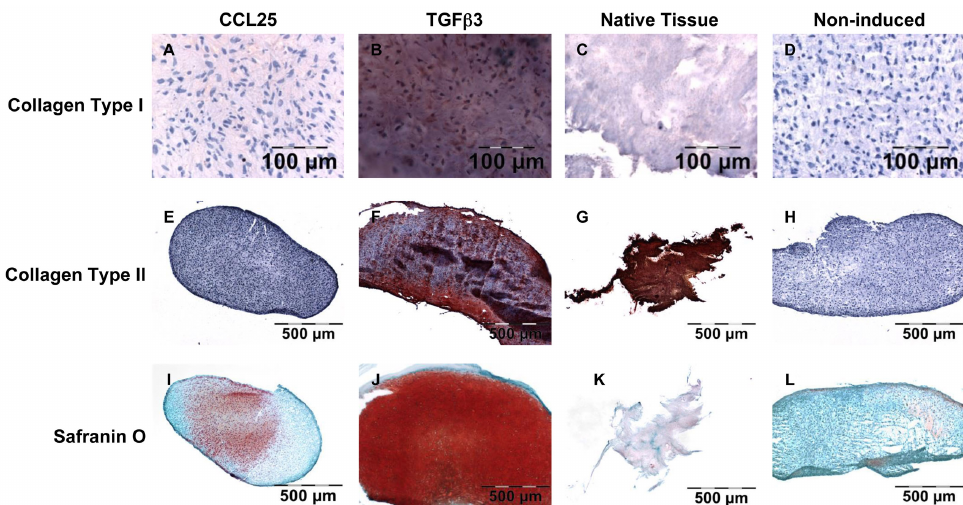
Figure 4. Histological and immunohistochemical staining. Exemplary visualization of collagen type I immunohistochemical staining of CCL25 induced ( A ), TGFβ3 induced ( B ) AF cells in pellet cultures; native AF tissue ( C ), and non-induced ( D ) AF cells in pellet cultures; collagen type II immunohistochemical staining of CCL25 induced ( E ), TGFβ3 induced ( F ) AF cells in pellet cultures; native AF tissue ( G ), and non-induced ( H ) AF cells in pellet cultures; safranin O staining of CCL25 induced ( I ), TGFβ3 induced ( J ) AF cells in pellet cultures; native AF tissue ( K ), and non-induced ( L ) AF cells in pellet cultures.